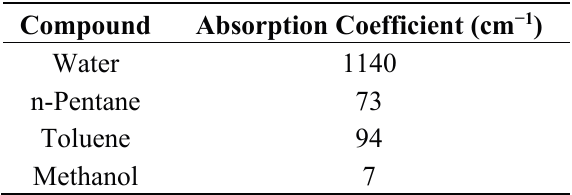
Table 4. Comparison of IR absorption coefficients in the bandwidth 3–5 µm using data from [53].